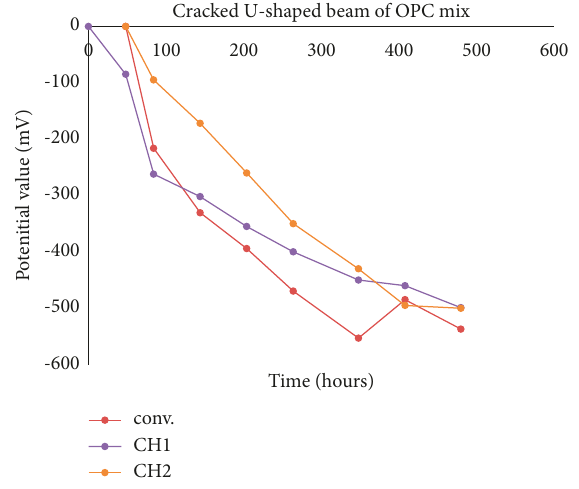
Figure 9: Cracked U-shaped beam of OPC mix.